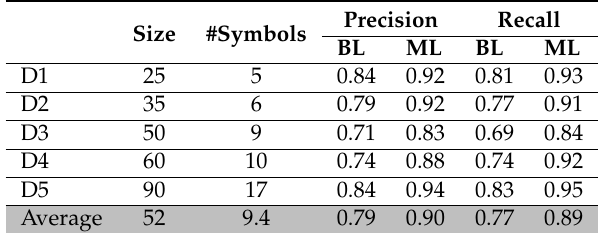
Table 3. Recognition rates for the baseline system (BL) and the proposed algorithm (ML). The size column indicates the number of strokes in each